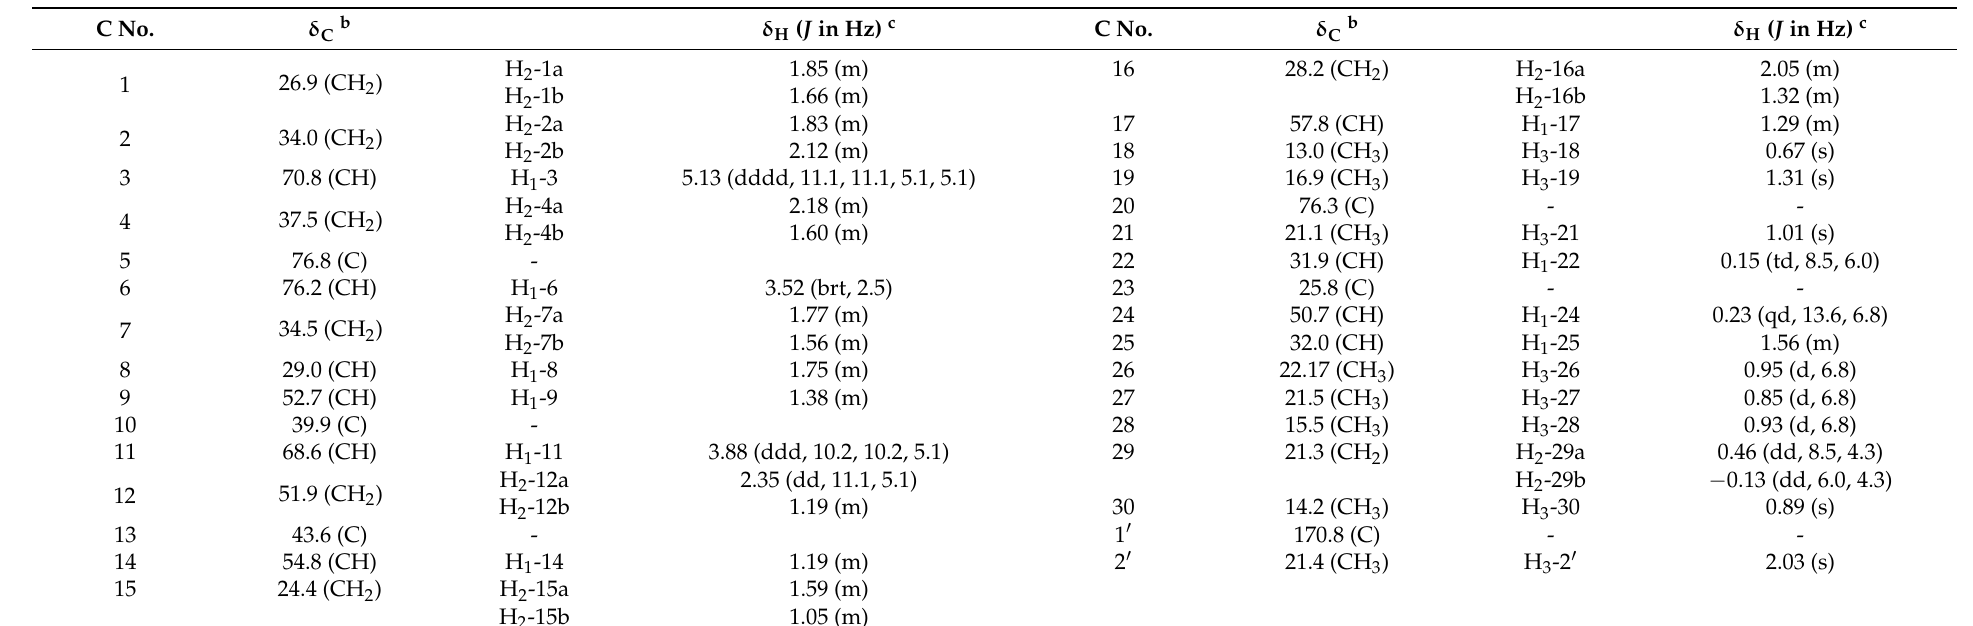
Table 2. 1 H and 13 C NMR spectral data of compound 7 a